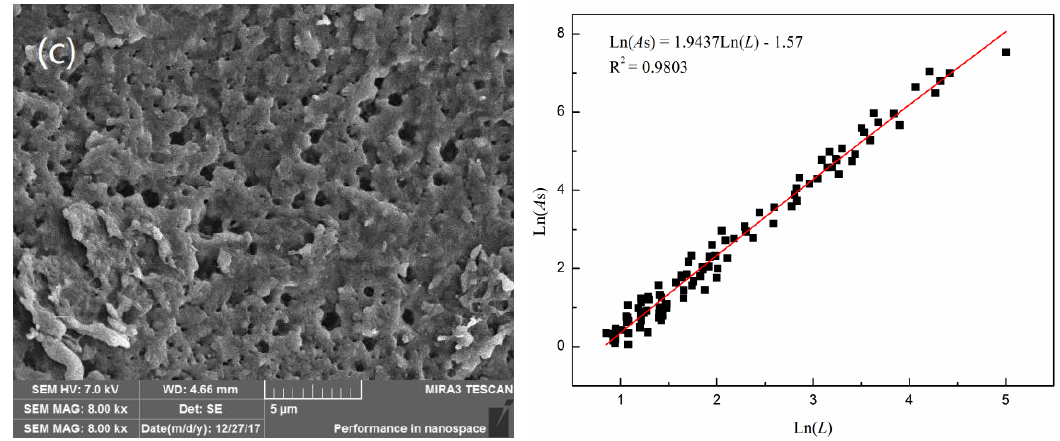
Figure 5. Morphology analysis of ( a ) CTS, ( b ) P(AM-DMC), and ( c ) CTS- g -P(AM-DMC).